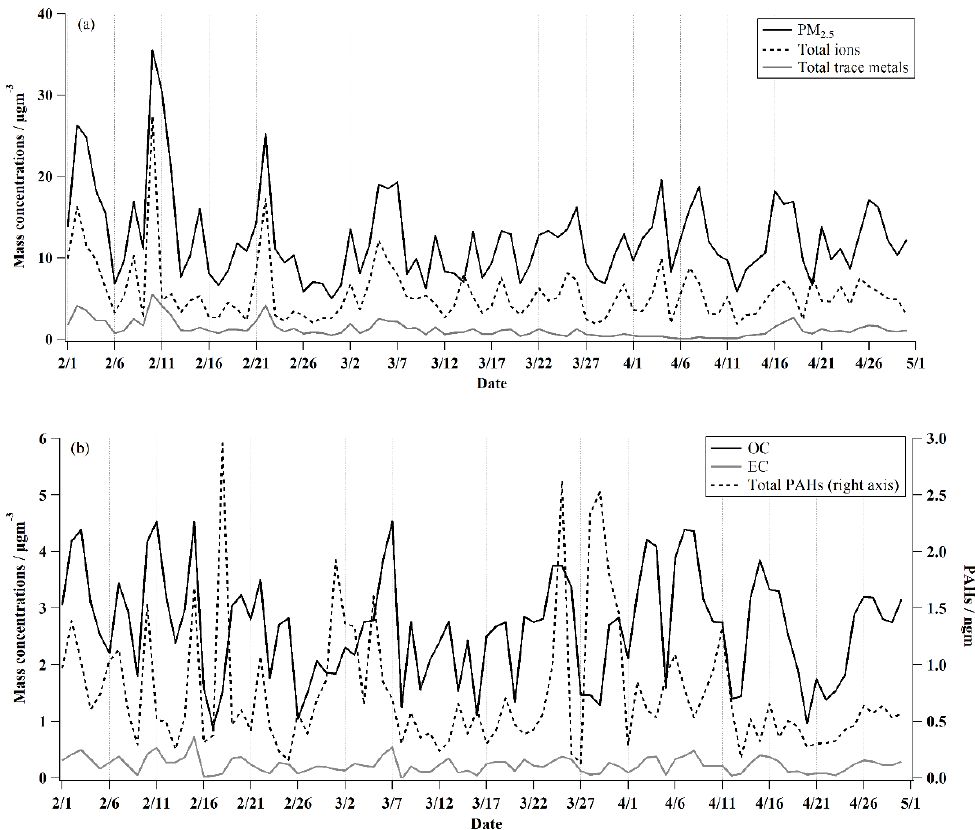
Figure 3. Time series of mass concentrations of PM 2 . 5 and its chemical component in spring 2020. ( a ) PM 2 . 5 , total ions, and total trace metals. ( b ) OC, EC, and total PAHs.